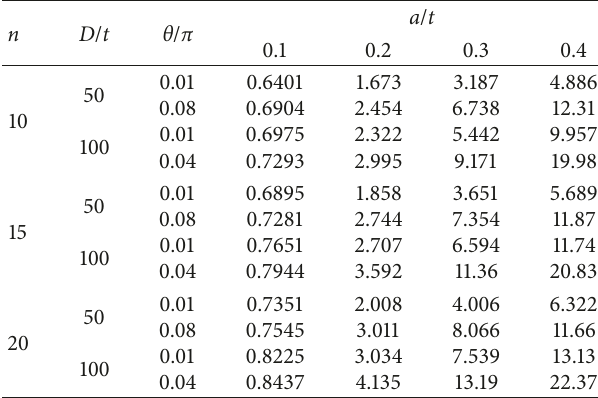
Table 3: Tabulated values of h 1 for thin-walled pipes under tension.